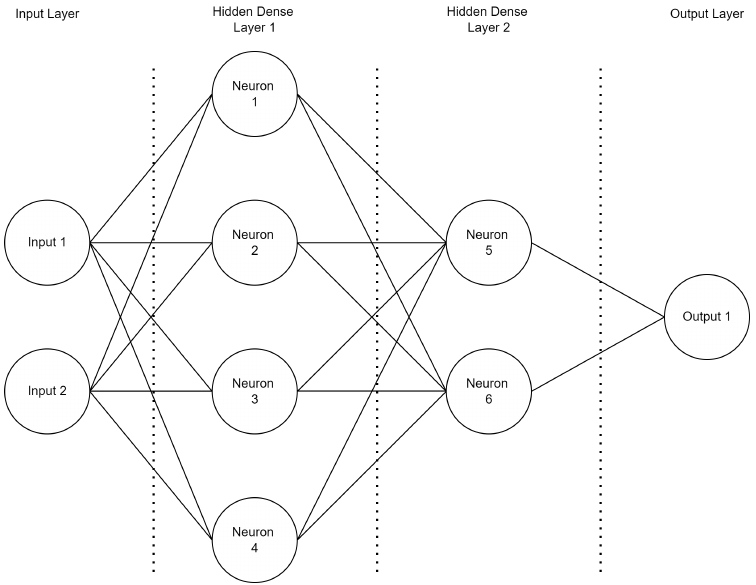
Figure 5. A high-level representation of the higher-order neural applied